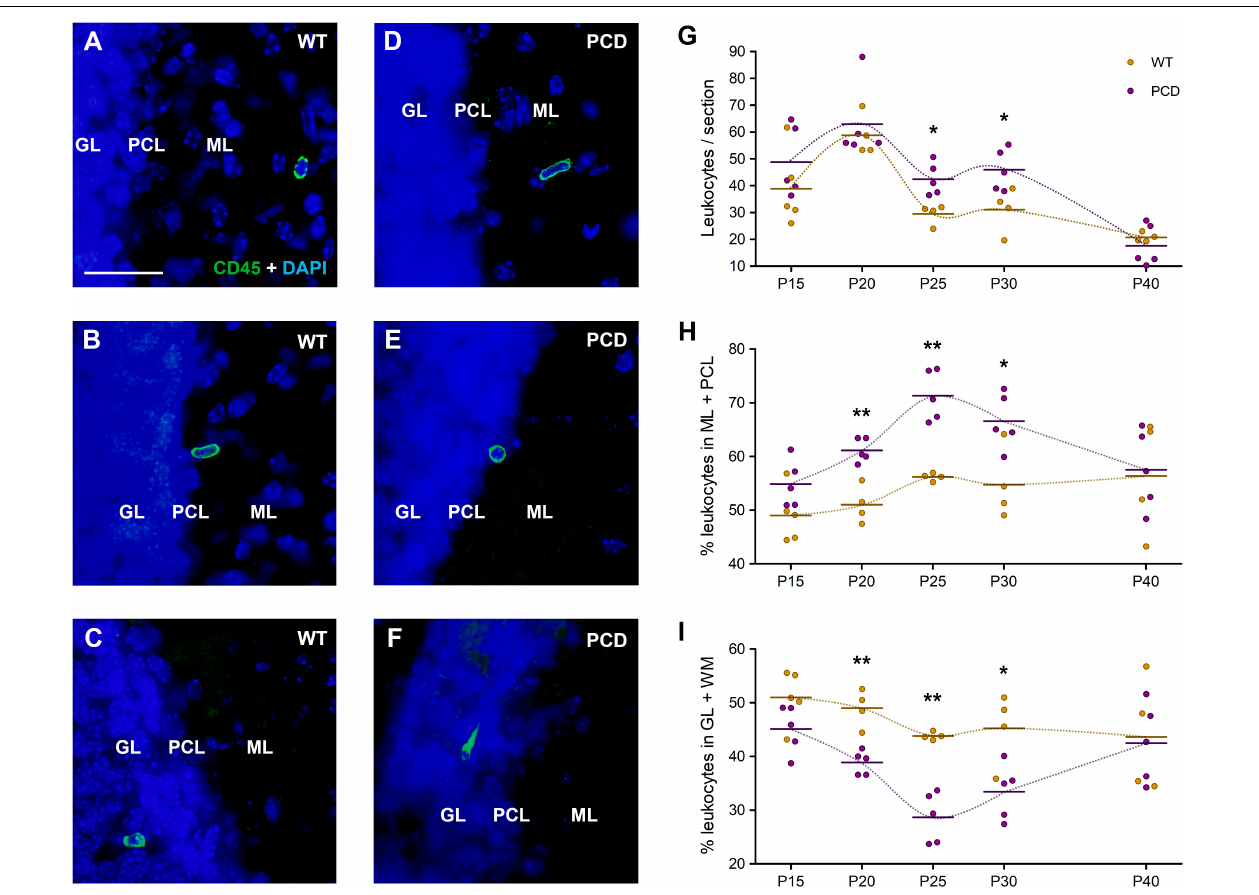
FIGURE 2 | Leukocyte infiltration and distribution in the cerebellum of WT and PCD mice. (A–F) Immunolabeling for CD45 (green) showing leukocytes in the different layers of the cerebellar cortex of both WT and PCD mice; nuclei are stained with DAPI (blue). (G) Chart showing the quantification of leukocytes per section of cerebellar vermis. (H,I) Graphs showing the proportional distribution of leukocytes in molecular and Purkinje cell layers (H) or granular layer plus the underlying white matter (I) ; these results are complementary. Note that differences in both the quantification and distribution were detected when the degeneration of Purkinje cells is in progress (from P20 to P30). Data are expressed as dot plots, where each dot represents one individual animal and horizontal lines represent the mean of each group. * p < 0.05; ** p < 0.01. GL, granular layer; PCL, Purkinje cell layer; ML, molecular layer. Scale bar: 25 µ